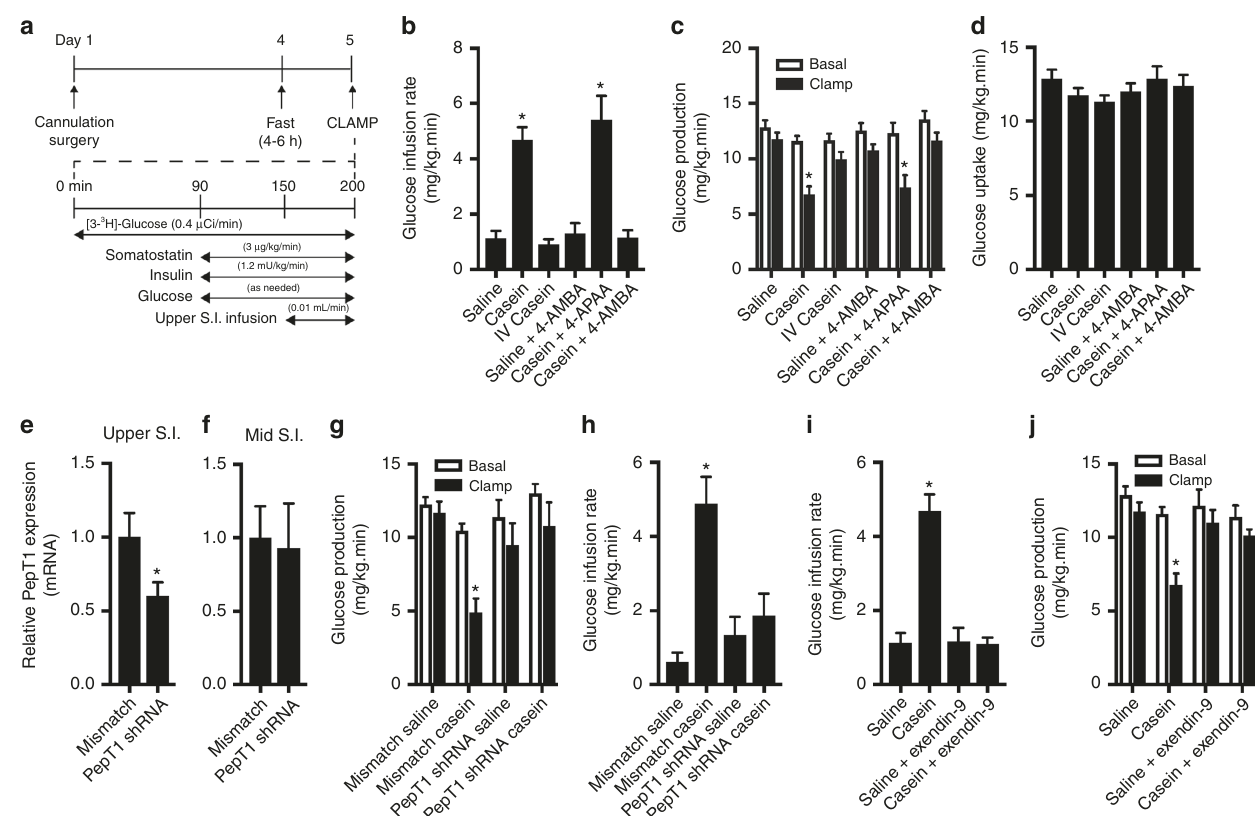
Fig. 3 Upper small intestinal casein infusion lowers glucose production through activation of PepT1 in healthy rodents. In vivo glucose kinetics were assessed in conscious, unrestrained healthy rats using the pancreatic (basal insulin) euglycemic clamp as outlined in a . Rates of glucose infusion ( b ), glucose production (GP, c ), and glucose uptake ( d ) in rats that received an upper small intestinal (S.I). infusion of saline ( n = 10) or casein ( n =